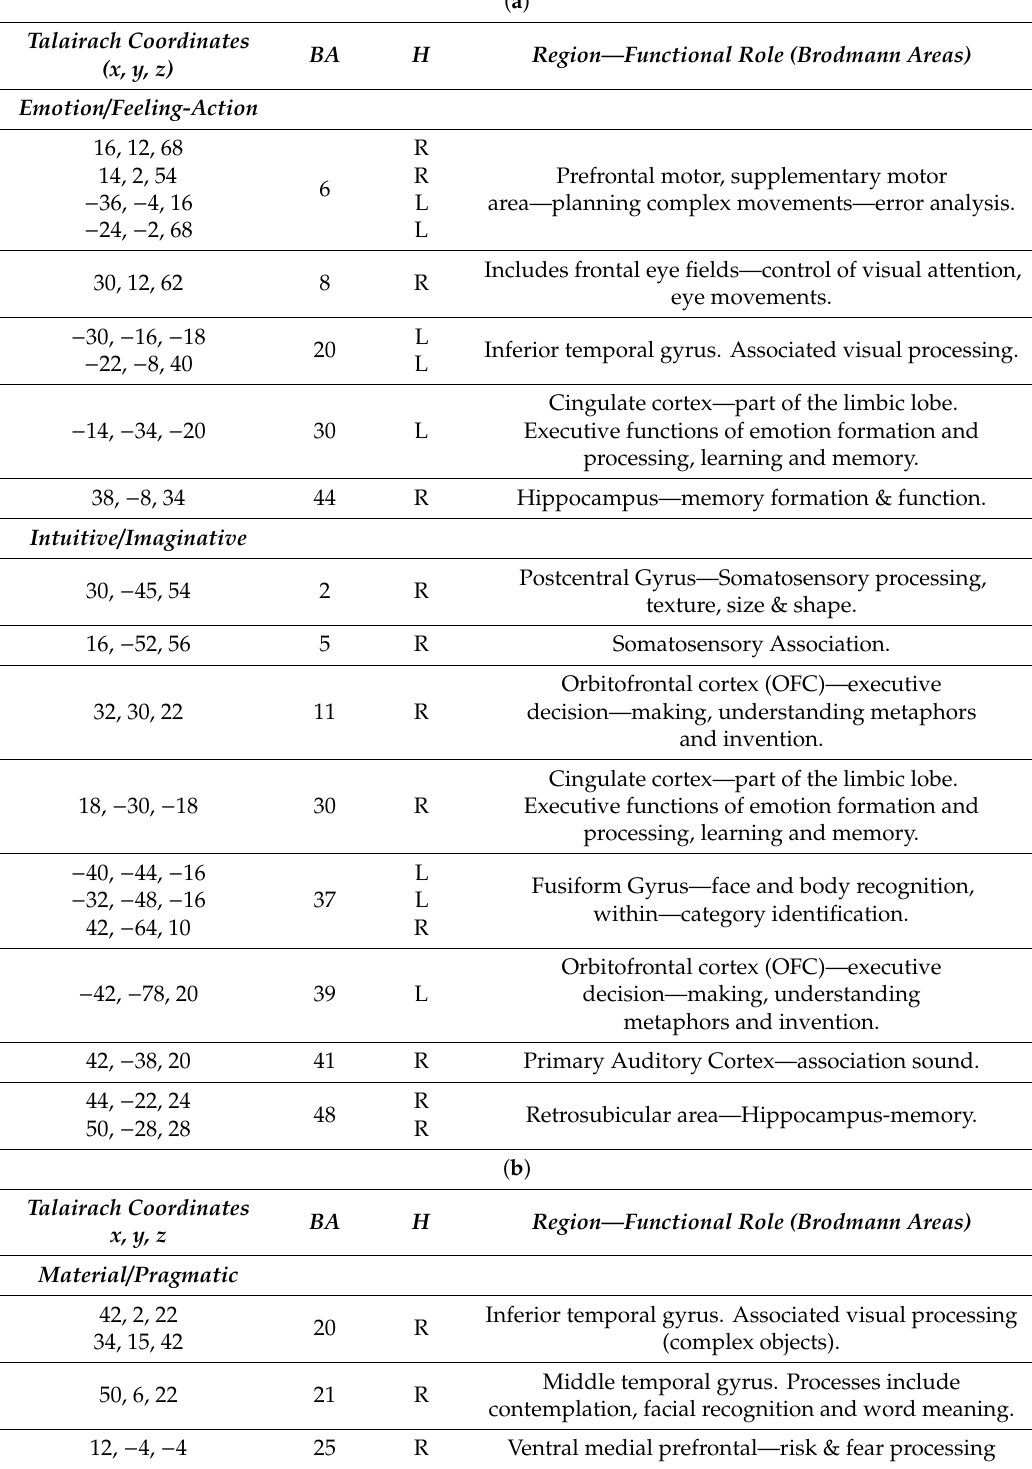
Table 1. ( a ) Group analysis (trait versus non-trait) contrast of Emotion / Feeling-Action PO and Imaginative / Intuitive PO ; region by Talairach coordinates, Brodmann area (BA), hemisphere (H), and function (significant activations p < 0.05). Note definitions of common functions based on previous work [52]. ( b ) Group analysis (trait versus Non-trait) contrast of Material / Pragmatic PO and Logical / Thinking PO ; region by Talairach coordinates, Brodmann area (BA), hemisphere (H), and function (significant activations p < 0.05). Note definitions of common functions, see